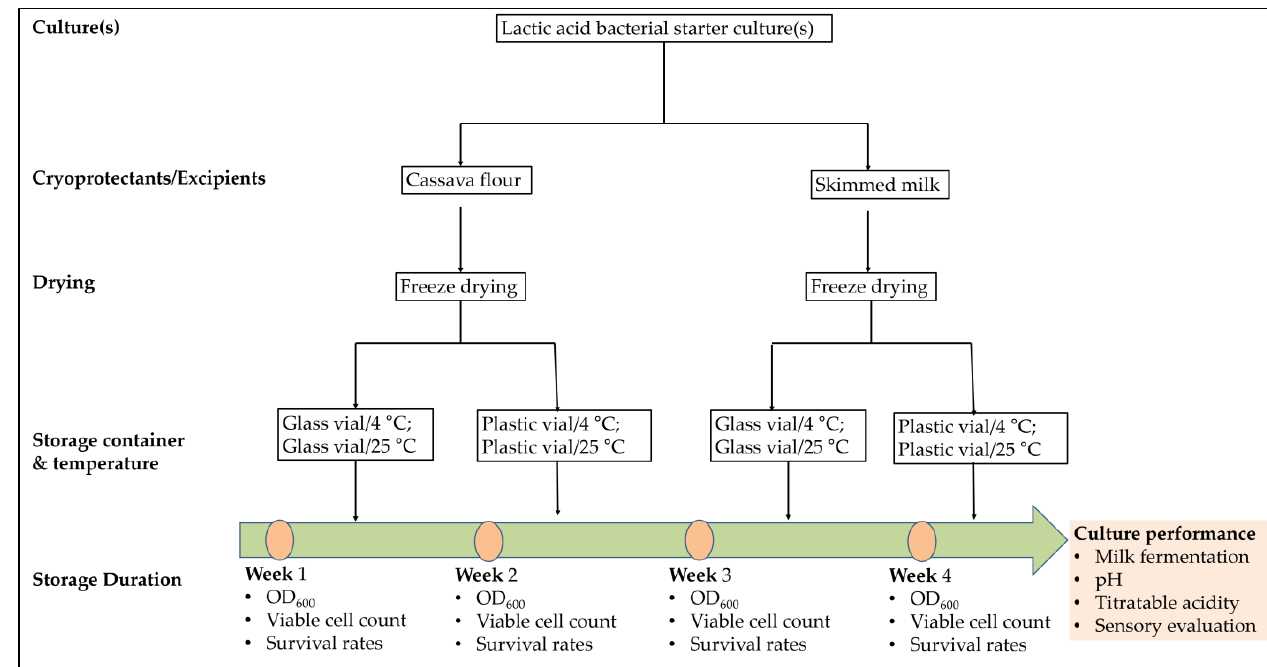
Figure 1. Study design; each selected lactic acid bacteria: Lactococcus lactis (L3), L. delbrueckii (L12), Leuconostoc mesenteroides (L20) and their combinations (L3 + L12, L3 + L20, L12 + L20, L3 + L12 + L20) go through these treatments.